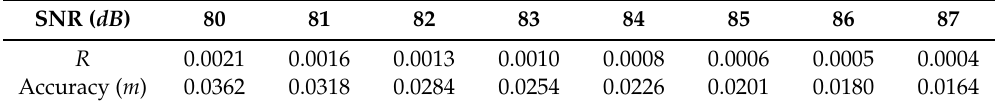
Table 1. The relation between R and the accuracy of Lidar.